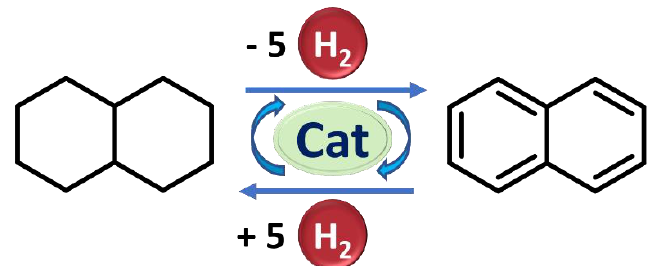
Figure 3. The schematic illustration of decalin / naphthalene LOHC system.